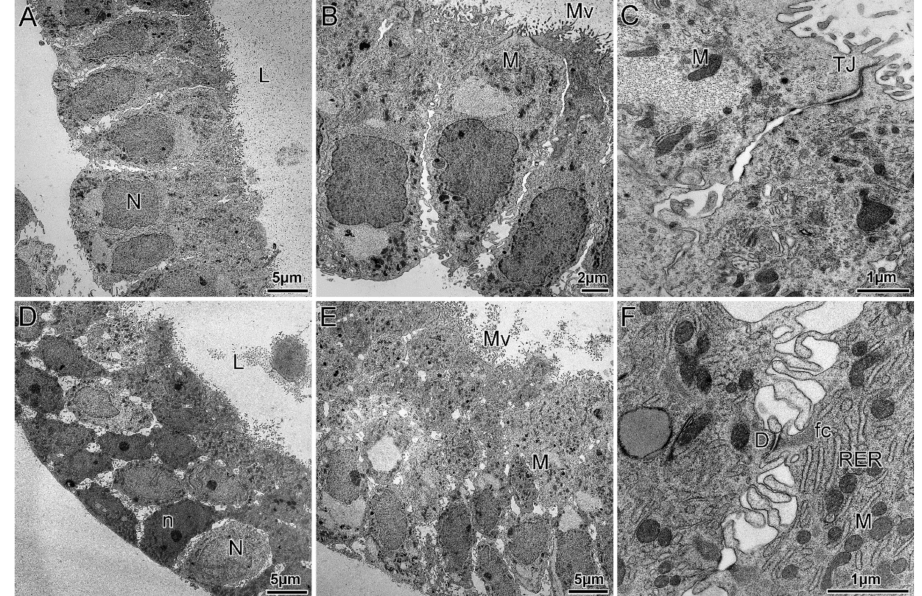
Figure 2. Ultrastructure of epithelial glandular organoids recapitulating the physiological architecture of glands in human healthy endometrium. ( A – C ) Representative electron micrographs of ORG-pp treated with E2 to mimic the proliferative phase, showing columnar epithelial cells forming a pseudostratified epithelium. ( D – F ). Representative electron micrographs of ORG-msp treated with E2, P4, cAMP to mimic the mid-secretory phase, showing a pluristratified epithelium lining the lumen. L, lumen; N, nucleus; M, mitochondria; Mv, microvilli; TJ, tight junction; D, desmosomes; n, nucleolus; RER, root endoplasmic reticulum; fc, filaments of